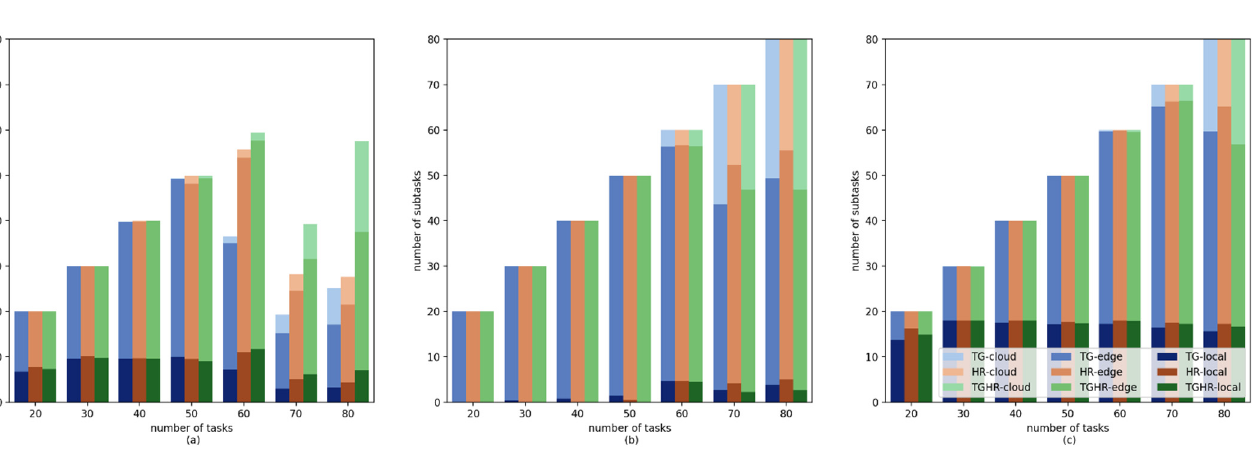
Figure 13. Allocation ratio of resource in different number of tasks. ( a ) Allocation ratio of resource in all Pareto fronts; ( b ) Allocation ratio of resource in near low-time 100 solutions; ( c ) Ratio of resource in near low-cost 100 solutions.